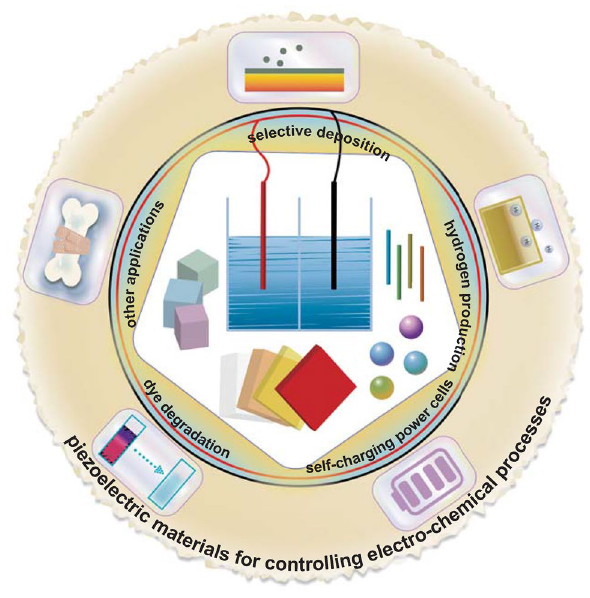
Fig. 1 Piezo‑electro‑chemical reaction systems to be covered in the review with various materials and practical